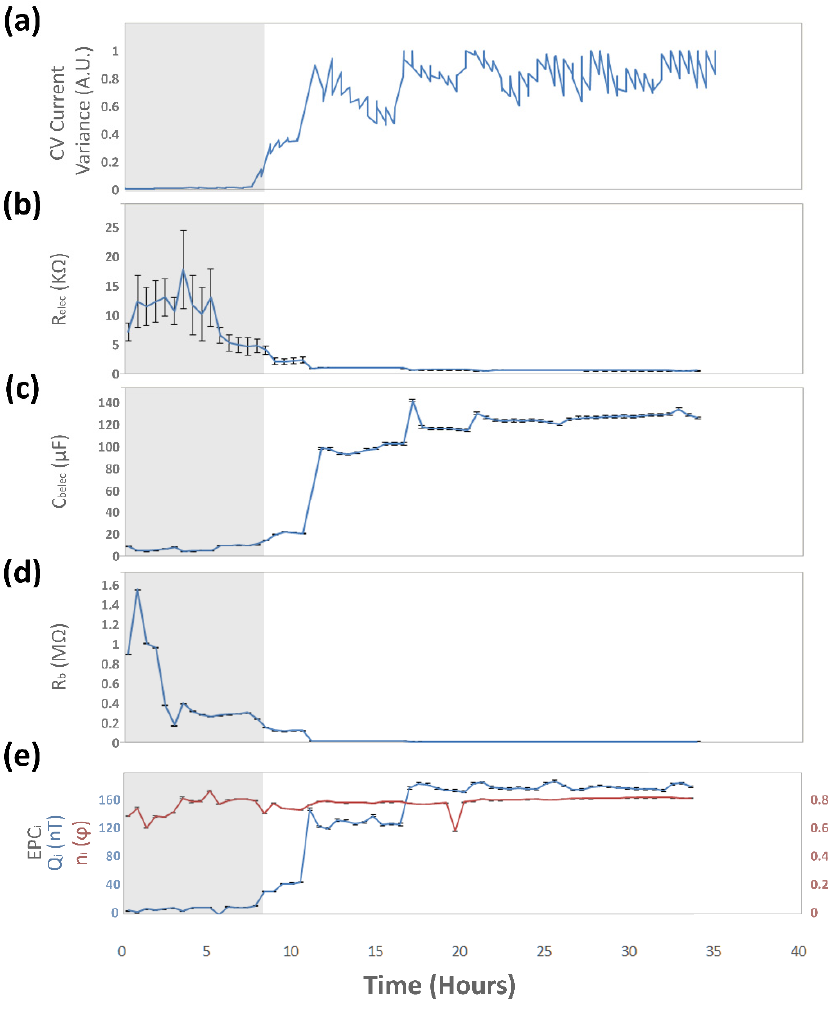
Figure 15. Changes of the simplified equivalent circuit over a 35-h period with a bacterial colonization event. ( a ) CV current variance analysis of the microsystem. ( b ) Microsystem resistance. ( c ) Electrode–bacteria interface capacitance. ( d ) Charge transfer resistance of the bacteria. ( e ) Constant phase element for the non-uniform accumulation of species at the electrode surface.